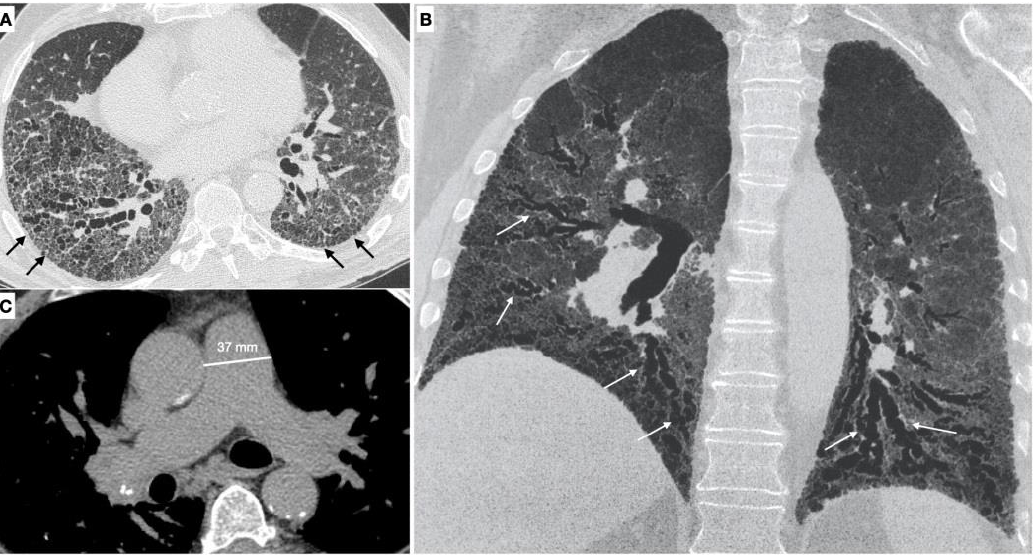
Figure 2. ( A , B ) Parenchymal signs: axial high resolution CT scan shows a fibrotic NSIP pattern due to the presence of diffuse irregular septal thickening (black arrows), bronchiectasis and bronchiolectasis on a background of diffuse ground glass opacities. Both lower lobes are symmetrically involved by these alterations. Bronchiectasis and bronchiolectasis (white arrows) are better visualized on the MinIP coronal plane reconstruction; ( C ) Vascular signs: a main pulmonary artery with a diameter greater than 36 mm measured in a scanning plane of its bifurcation is a sign of pulmonary hypertension.